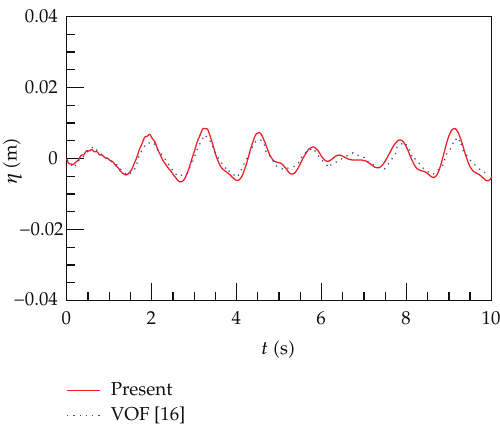
Figure 5: Time history of wave surface at the right tank wall with a vertical ba ffl e.